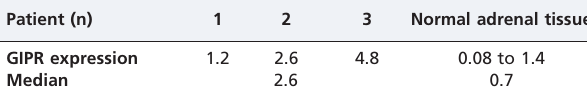
Table 2 - GIPR expression in adrenal tissue from 3 patients with MEN1 syndrome as compared with the normal human adrenal gland pool (median).